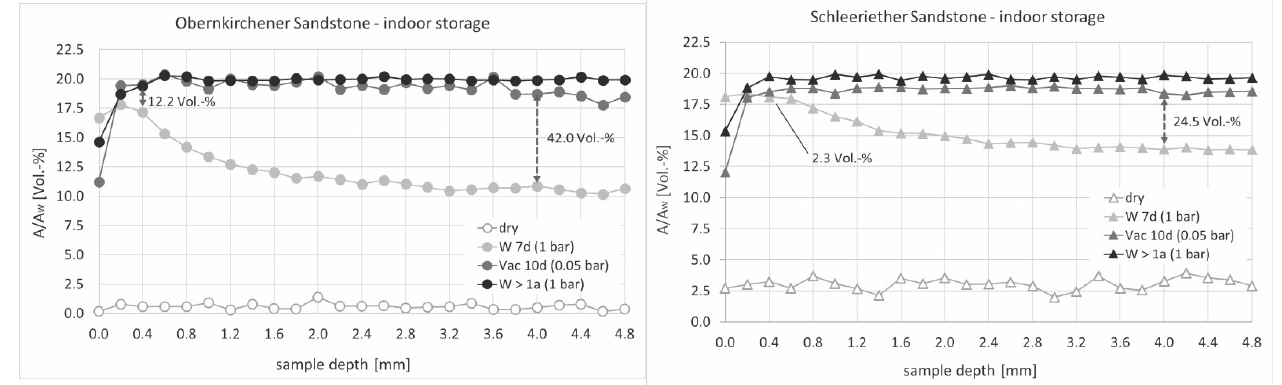
Figure 5. Depth profiles at different saturation levels for unweathered Obernkirchener and Schleerither Sandstones.